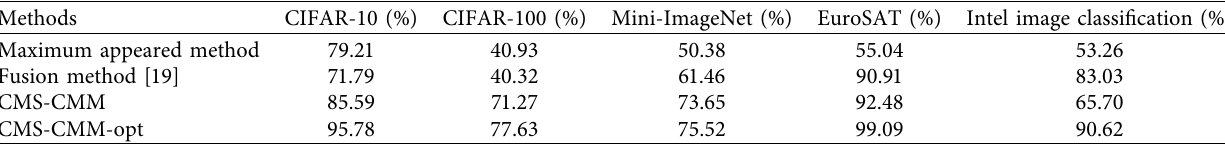
Table 1: Evaluation based on CD (the accuracy of predicting correct domains).